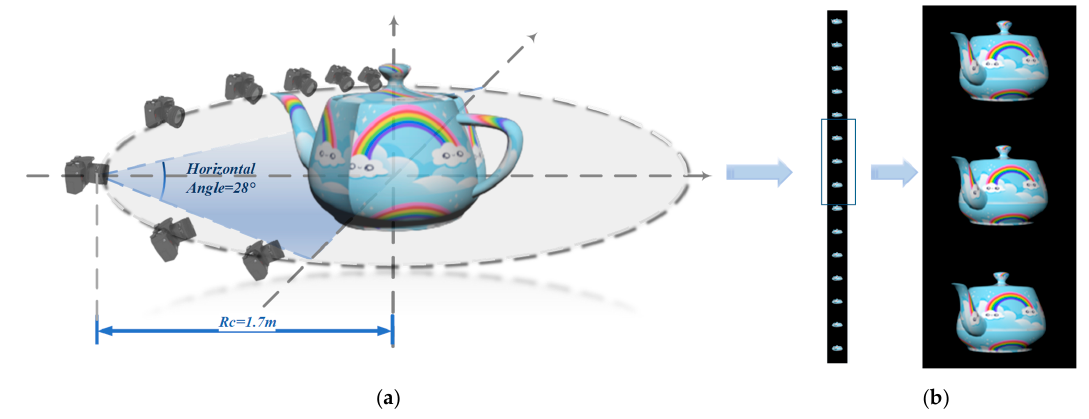
Figure 7. Scene setting of the virtual acquisition terminal ( a ) and PIs obtained by capture ( b ) .